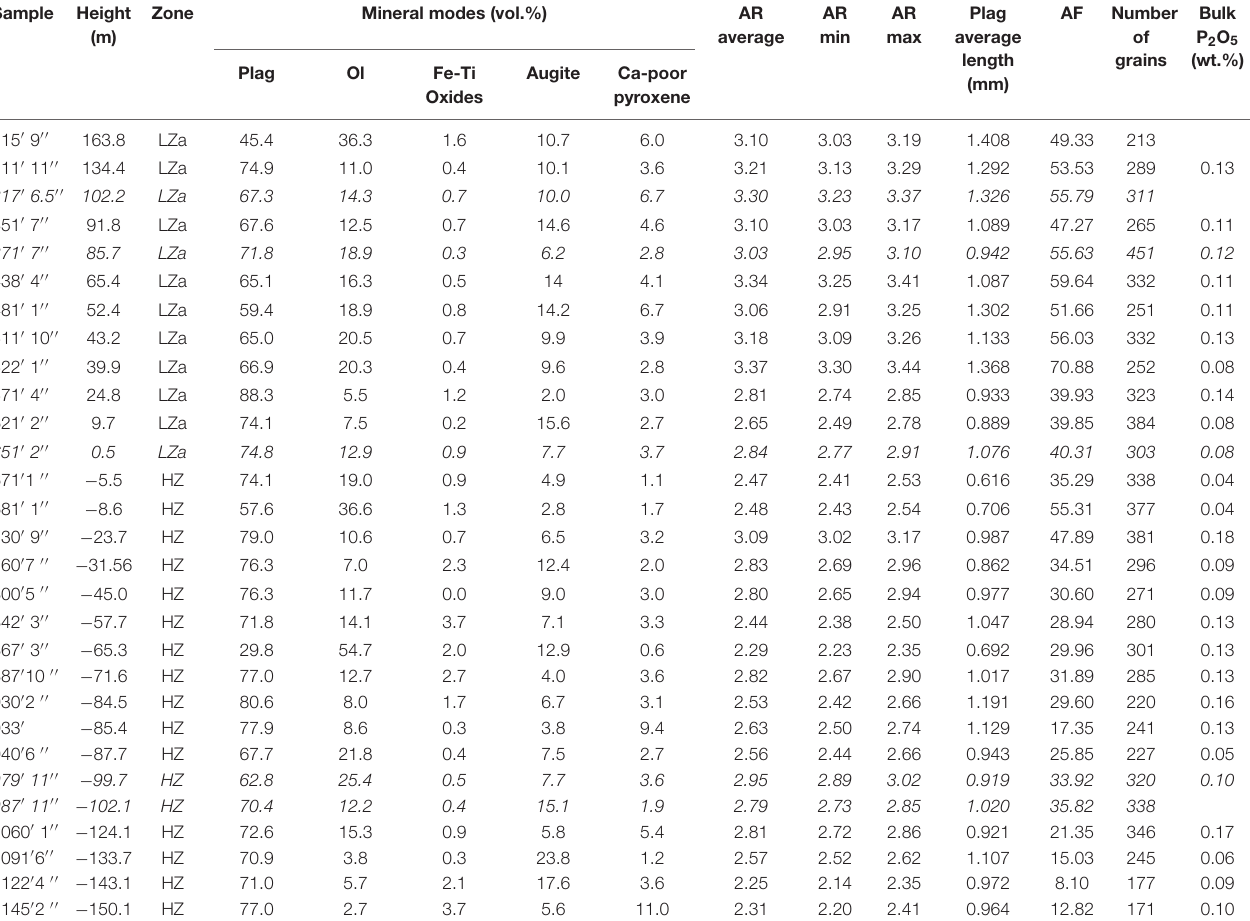
TABLE 1 | Details of troctolitic samples from the Cambridge 1966 drill core through the lower part of the Skaergaard Layered Series. Sample Height Zone Mineral modes (m)